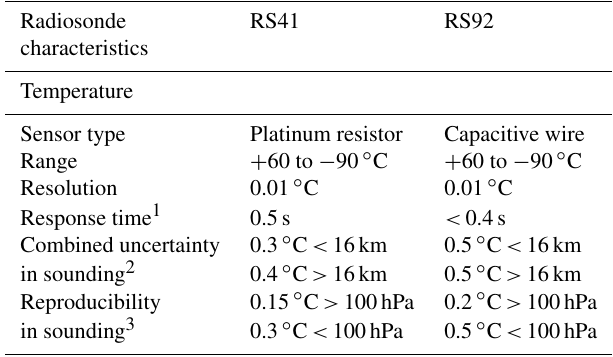
Table 2. Radiosonde temperature sensor manufacturer specifica- tions (based on Table 3 from Jauhiainen et al.,